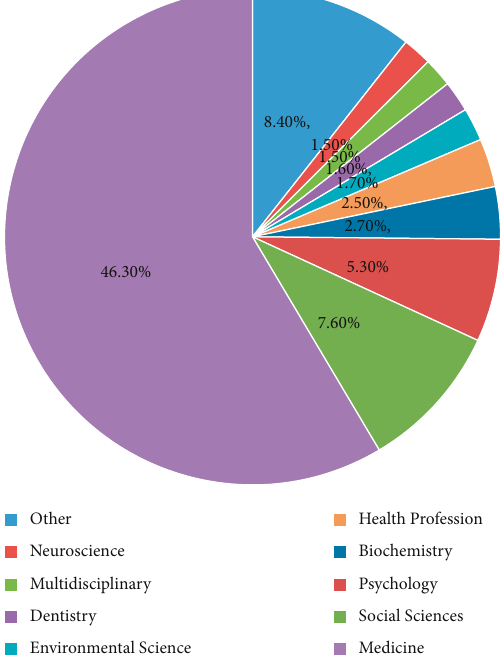
Figure 31: Pie chart depicting article distribution by disciplines for qualitative systematic review articles.